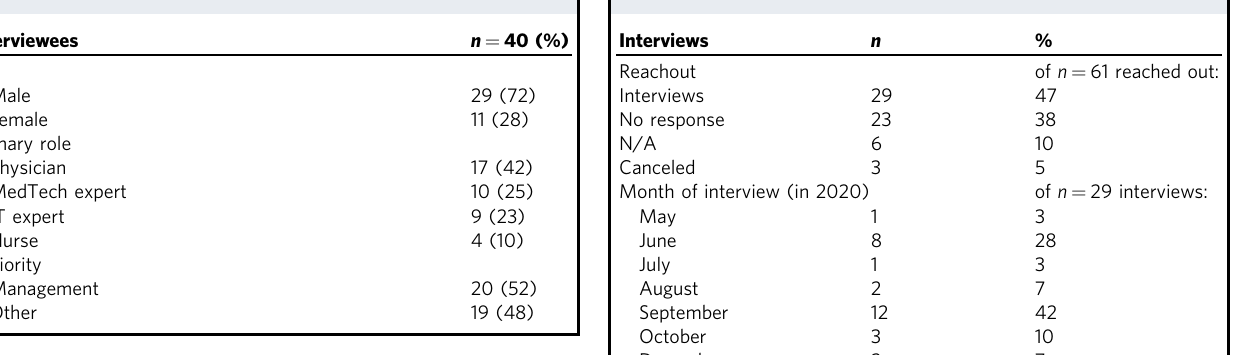
Table 2 VoC interviewee demographics. Table 3 VoC interview